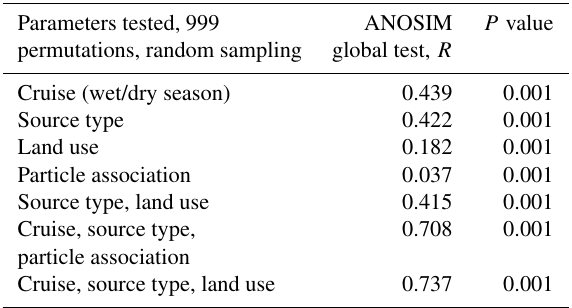
Table 1. ANOSIM global test scores based on various parameters.